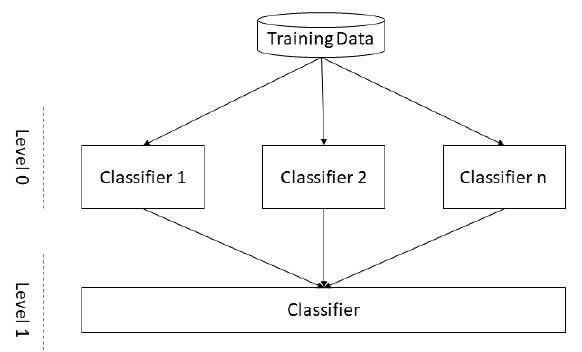
Figure 5. Concept diagram of